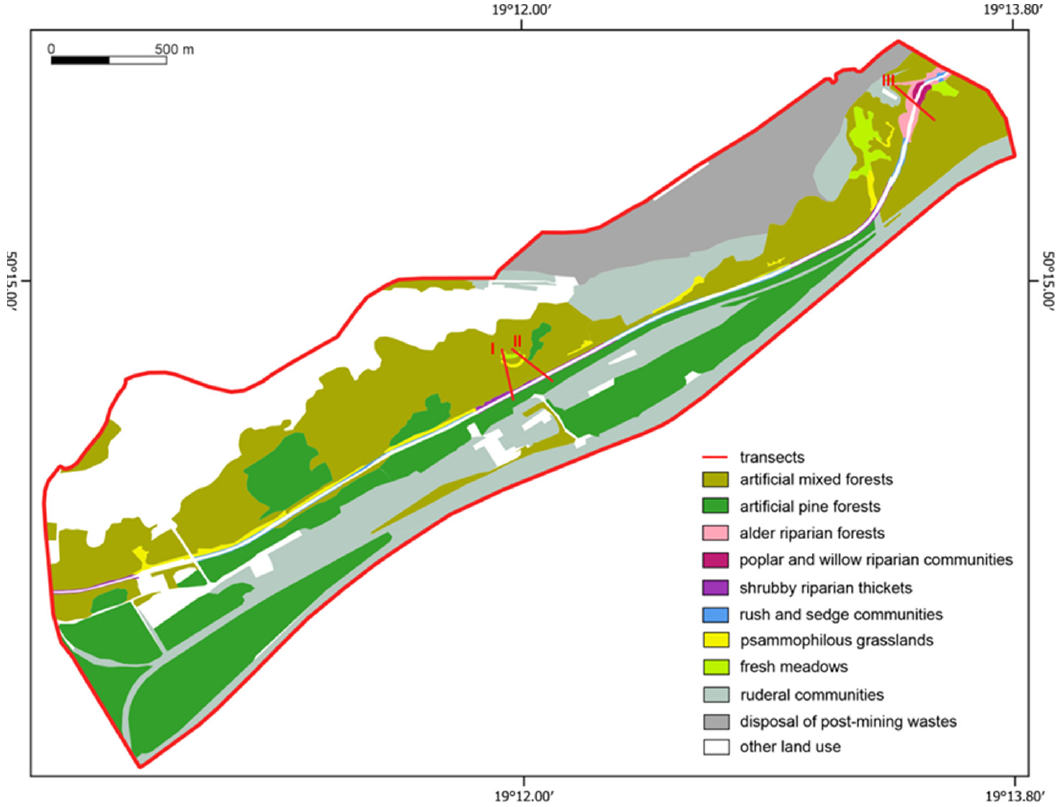
Figure 4. The distribution of modern contemporary vegetation communities in the study area.